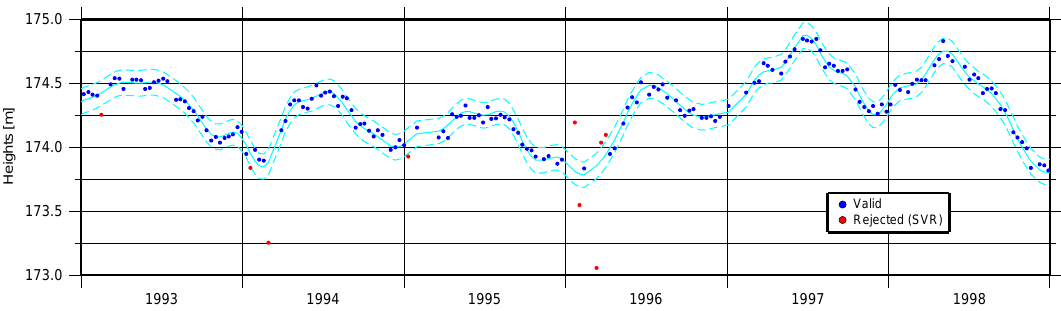
Jiparaná River, Paraguay River, Madeira River, and the